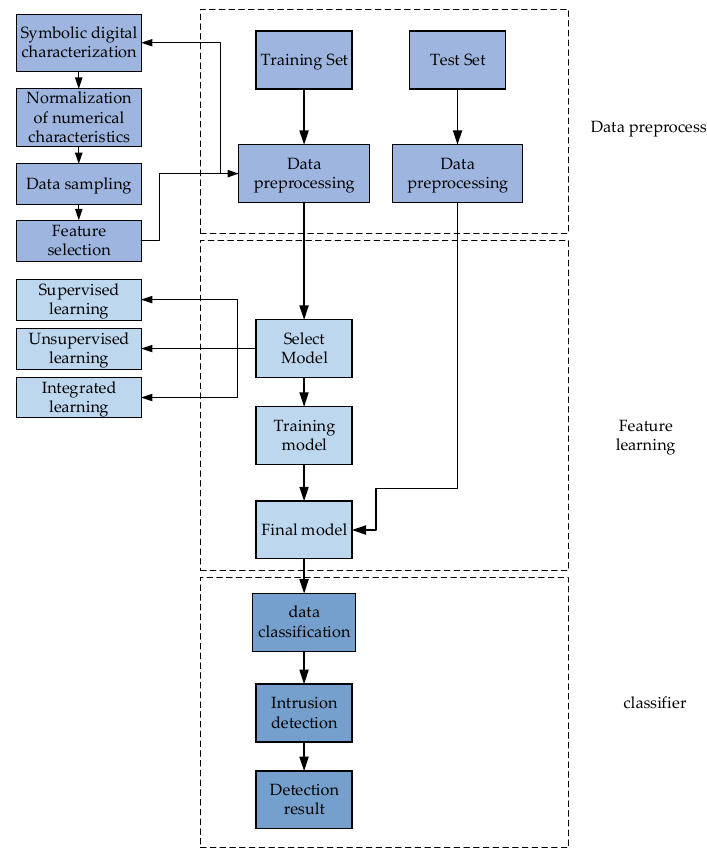
Figure 2. Flowchart of intrusion detection based on machine learning.